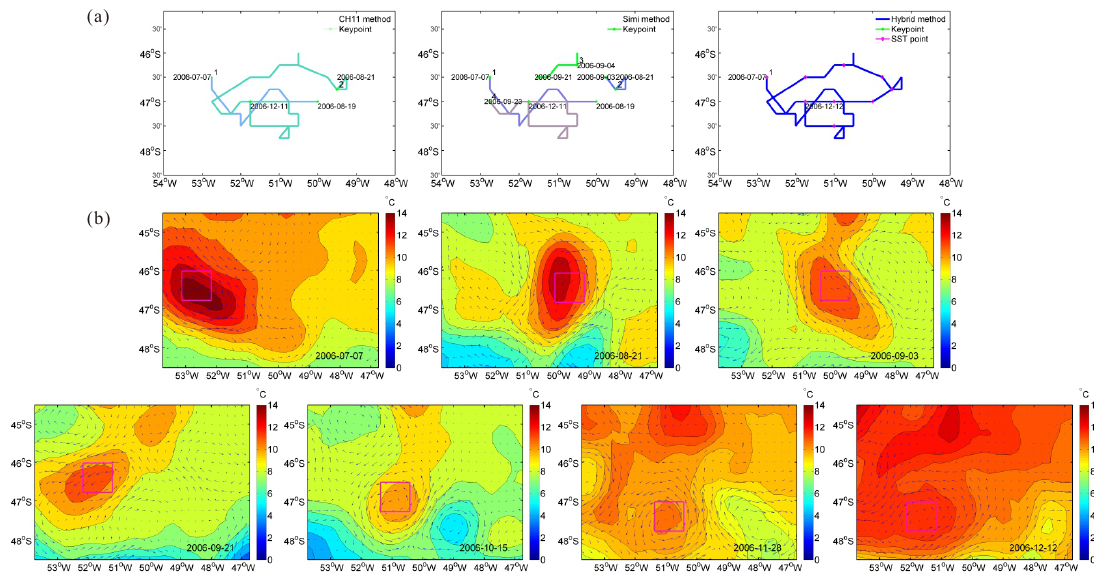
Figure 6. ( a ) Anticyclonic eddy off the west coast of the South Atlantic Ocean tracked using three methods (CH11, similarity and hybrid methods, from left to right) in 2006; ( b ) SST and geostrophic current field extracted from the eddy region. This eddy splits into two parts while propagating. Only the hybrid method could tolerate the split and continue tracking it using the major feature of the “mother” eddy.